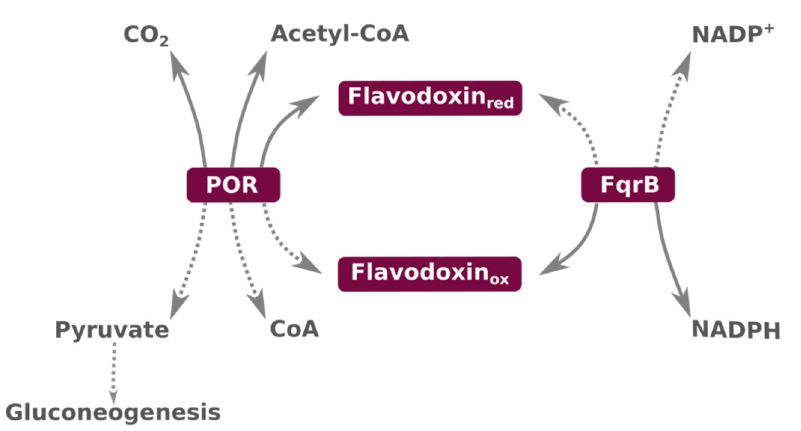
Figure 2. The POR:FldA:FqrB pathway in H. pylori . Flavodoxin (Fld) shuttles electrons between pyruvate oxidoreductase complex (POR) and flavodoxin:quinone reductase (FqrB) in a reversible pathway which plays a central role in the bacterial metabolism, as it represents an essential route for CO 2 fixation and pyruvate metabolism. The pyruvate decarboxylation pathway is represented by solid lines, whereas the pyruvate synthesis pathway (contributing to gluconeogenesis) is indicated by dotted lines. Adapted from Reference [46].